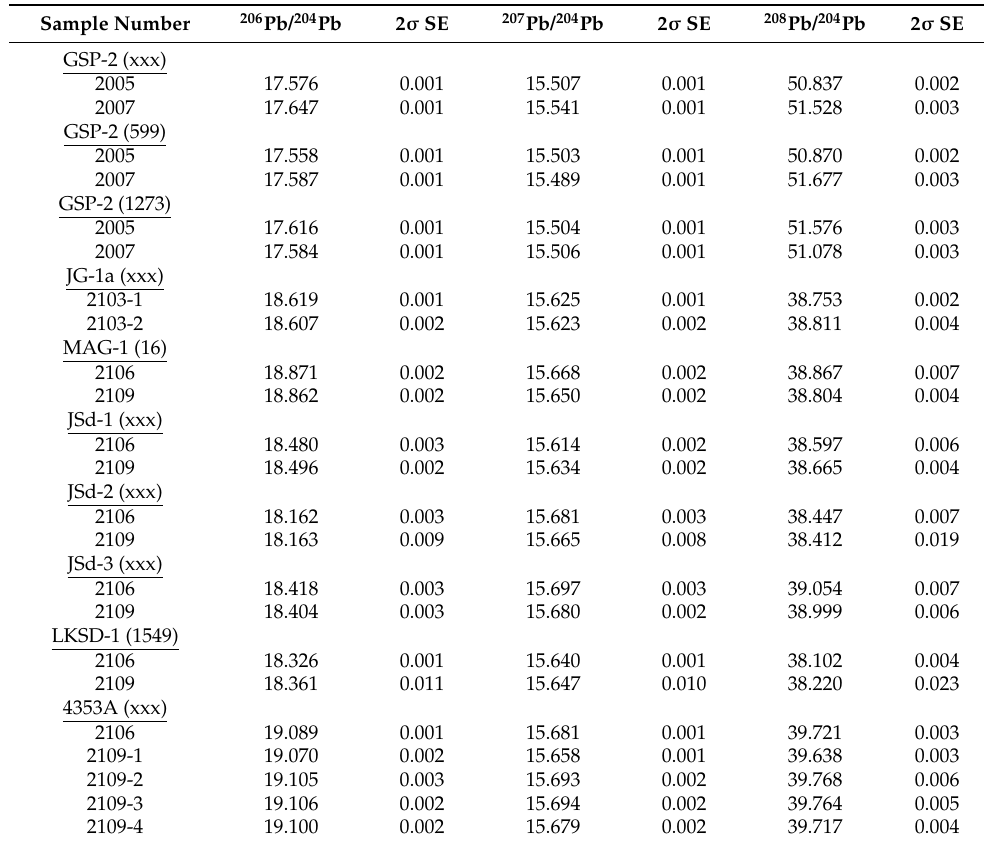
Table 6. Pb isotopic compositions of rock